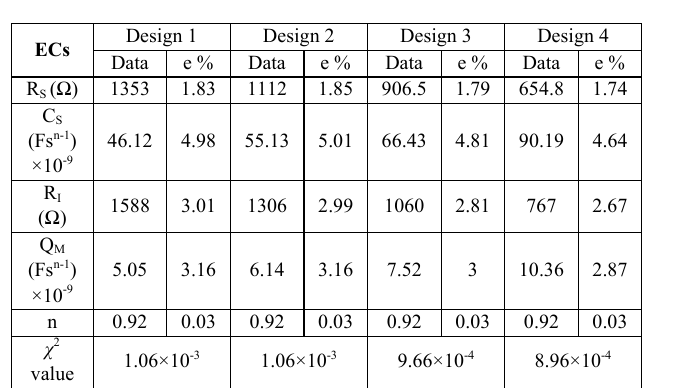
Table 2. Values of electric components of blood for different designs with relative standard error (e %)